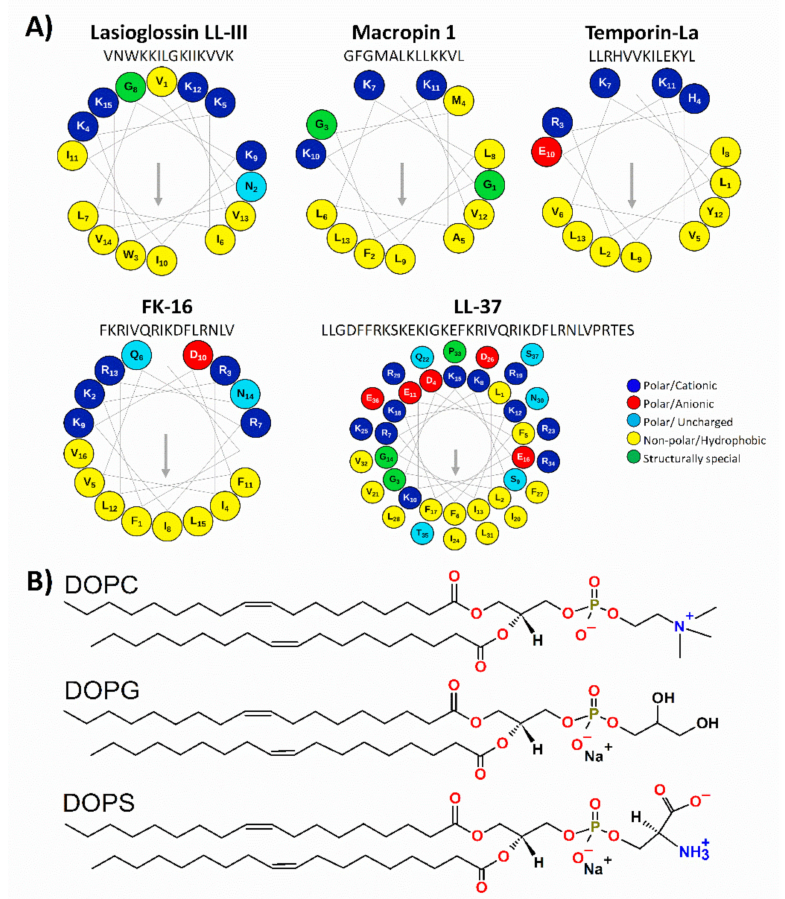
TEMPO-LA Electrostatic